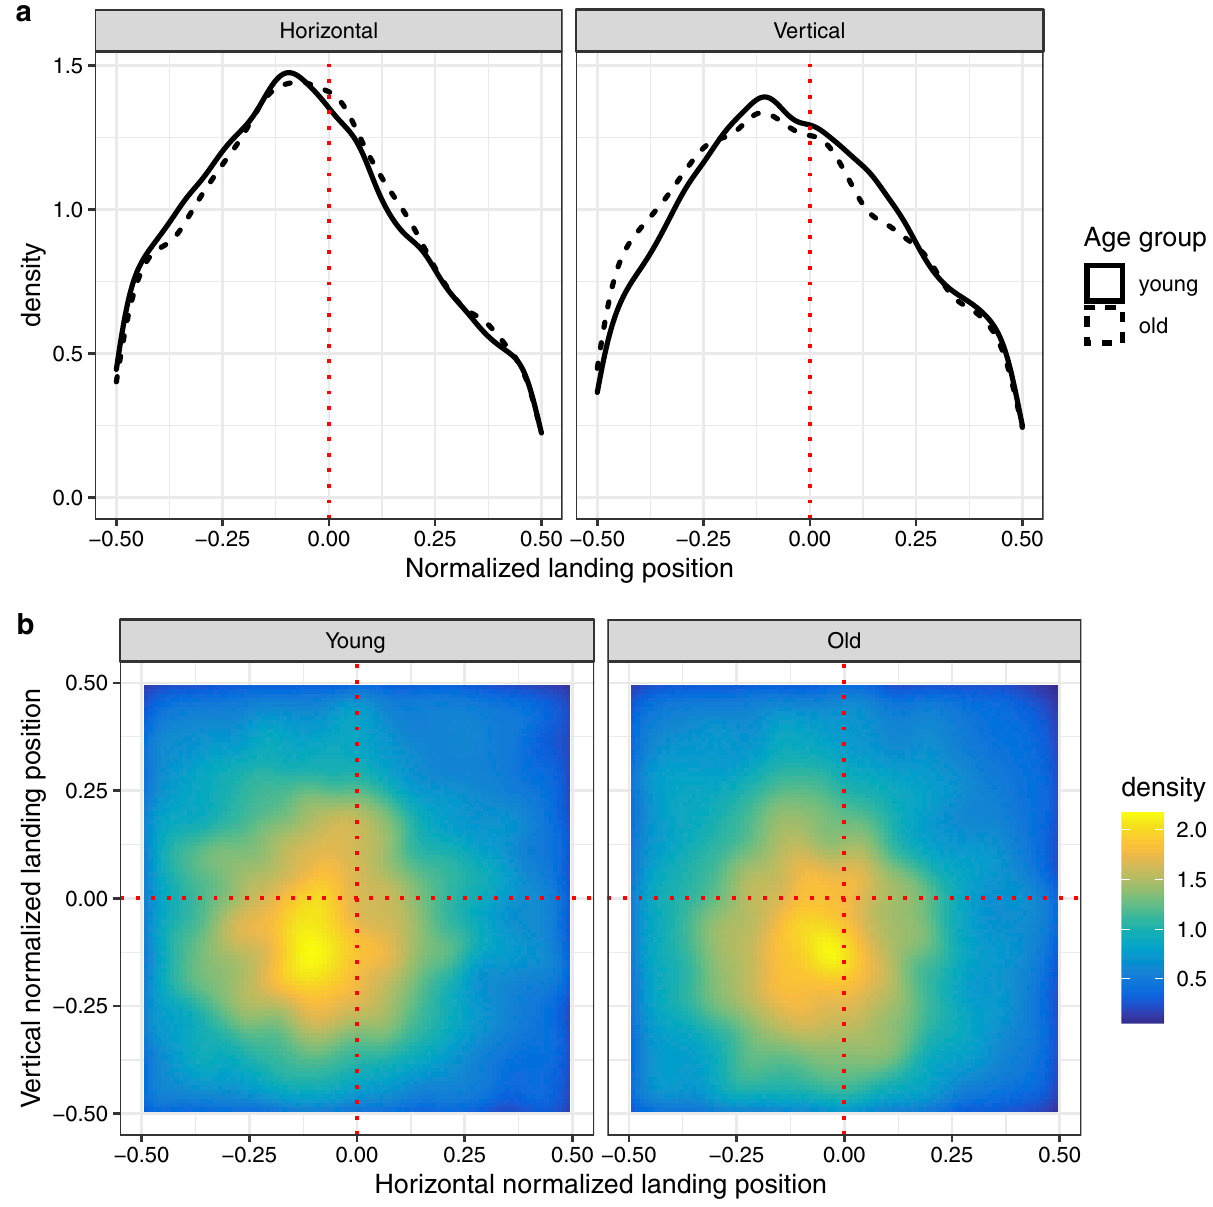
Figure 6. Preferred viewing location for objects in scenes. Analyses were based on initial fixations on objects. ( a ) Distributions of the horizontal (left panel) and vertical (right panel) components of normalized within- object landing positions are directly compared for young adults (solid line) and older adults (broken line). In both panels, the vertical red dotted line marks a landing position at the centre of the object. ( b ) Corresponding smoothed two-dimensional viewing location histograms for young adults (left panel) and older adults (right panel). The frequency information is displayed as variations in colour, with colours ranging from blue (few fixations) to yellow (many fixations) and passing through green and orange. The intersection of the two red dotted lines marks the centre of the object. See text for details on the normalization